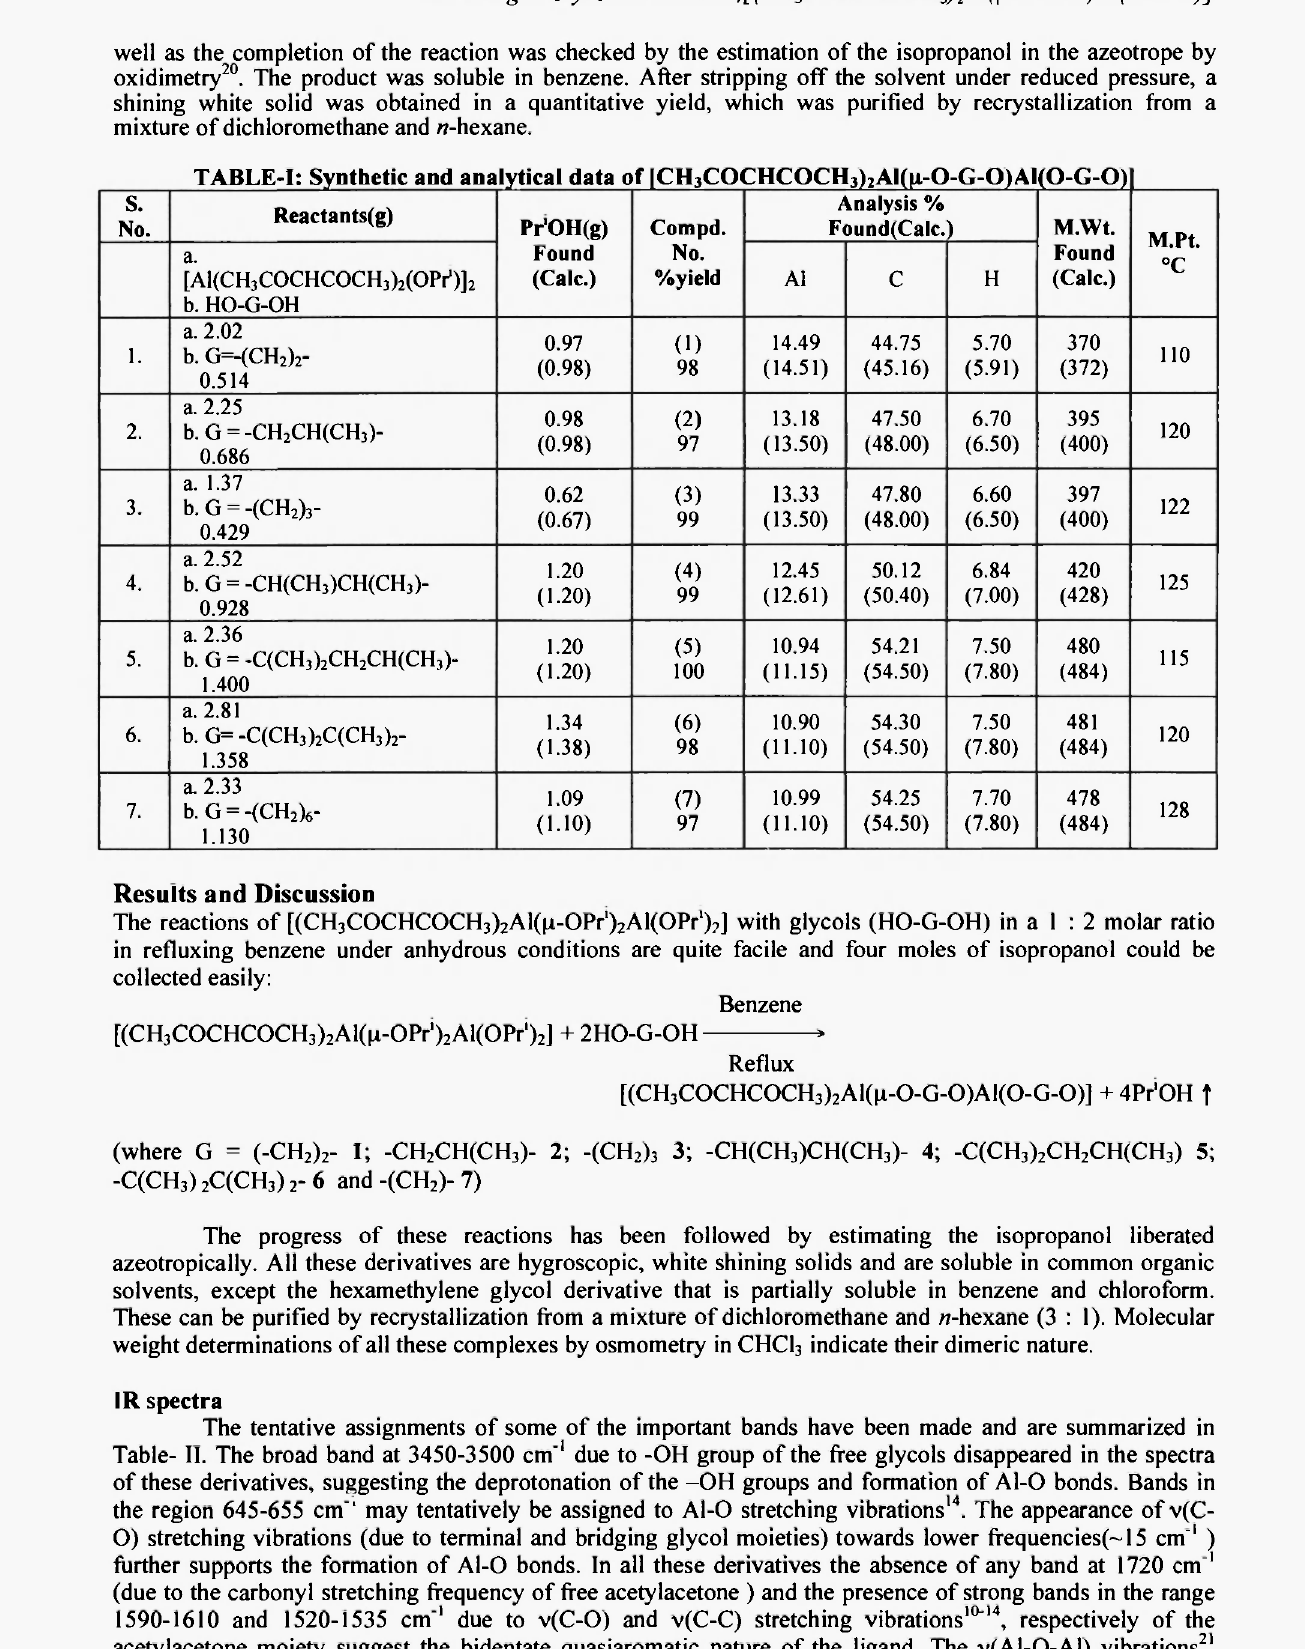
TABLE-1: Synthetic and analytical data of |CH 3 C0CHC0CH 3 ) 2 AI^-0-G-0)AI(0-G-Q)